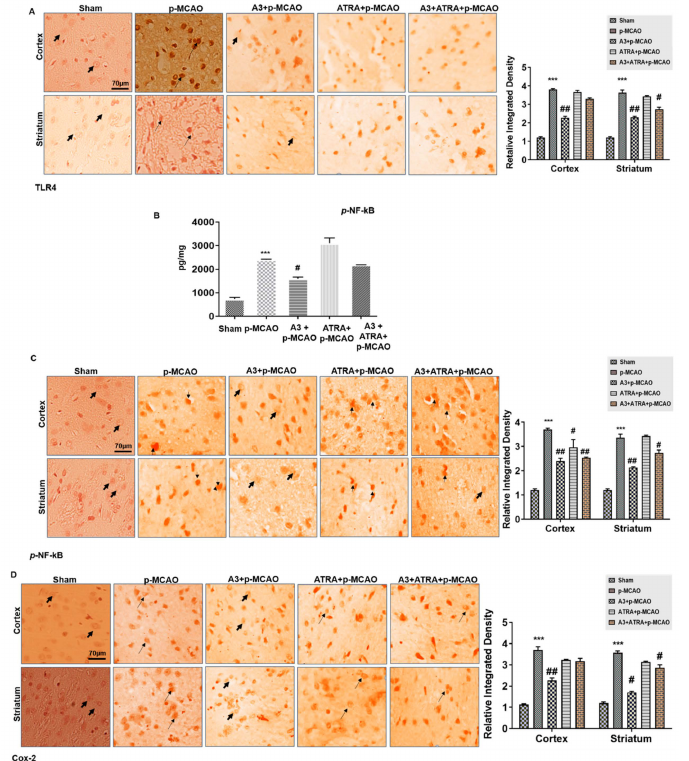
Figure 6. A3 ameliorated p-MCAO-induced neuroinflammation. ( A ) The release of TNF- α was quantified by ELISA in the cortex. *** p < 0.001 vs. sham, ## p < 0.01 vs. p-MCAO ( n = 5 / group). ( B ) Immunohistochemical results for TNF- α in cortex and striatum tissues of the brain. Scale bar = 70 µ m, magnification 40 × ( n = 5 / group). TNF- α exhibited cytoplasmic localization in both examined brain areas. ( C ) Immunohistochemistry results for p-JNK in cortex and striatum tissues of the brain. Scale bar = 70 µ m, magnification 40 × , ( n = 5 / group). p-JNK exhibited cytoplasmic localization. *** p < 0.001 vs. sham, # p < 0.05 or ## p < 0.01 vs. p-MCAO group. The bold arrow indicates no expression while thin arrow indicates cytoplasmic localization of TNF- α and p-JNK.